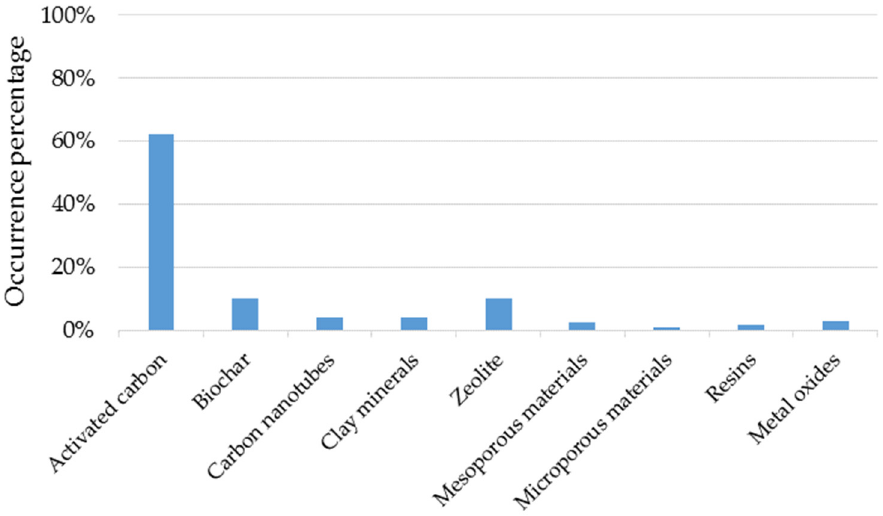
Figure 9. Adsorbents used during the adsorption